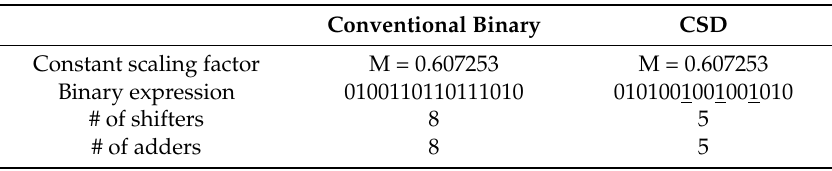
Table 2. Binary representation of the constant multiplier in conventional way and canonical signed digit